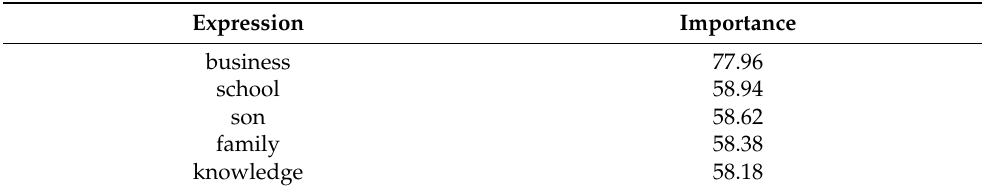
Table 4. Weight of criteria: successor